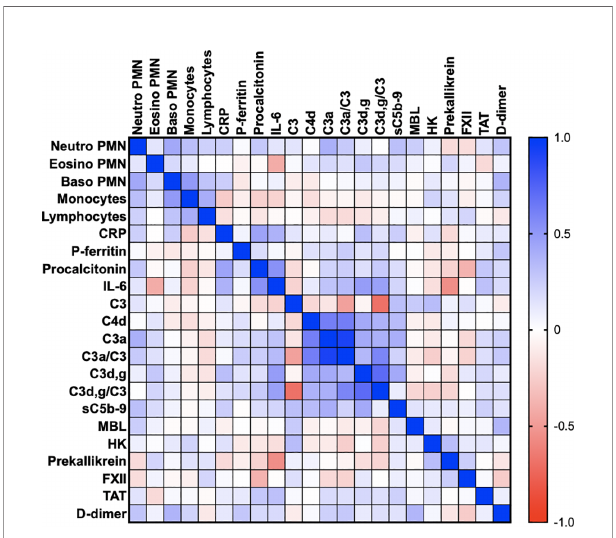
FIGURE 2 | Thromboin fl ammation activation in critically ill COVID-19 patients. Thromboin fl ammatory parameters from 66 consecutive patients with COVID- 19 were analyzed by the Spearman correlation test and presented in a heat map. Multiple signi fi cant correlations within each cascade system and also between the cascade systems, blood cell counts, CRP, and IL-6 were found. A summary of the most important correlations is presented in Table 3 . TAT, thrombin-antithrombin.